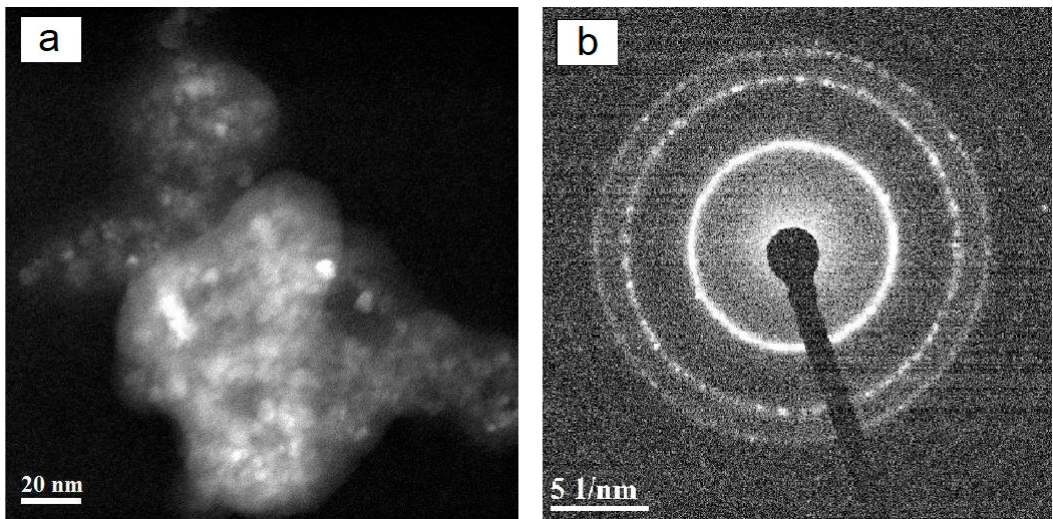
Figure 4. Morphological and structural characterizations of a functionalized DNDs aggregate: ( a ) scanning TEM high-angle annular dark field (HAADF) image, ( b ) selected area diffraction (SAED) pattern.